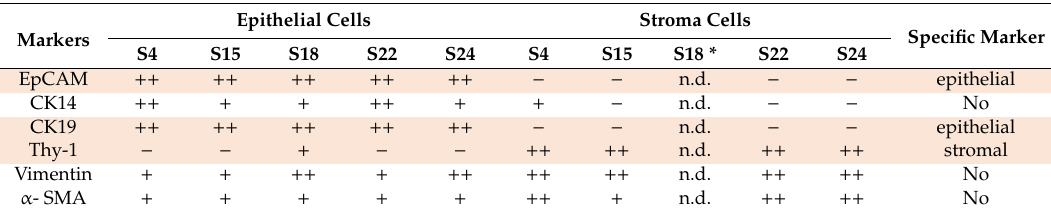
Table 1. Specific markers for the distinction of primary epithelial and stromal cells derived from individual HNSCC tissue